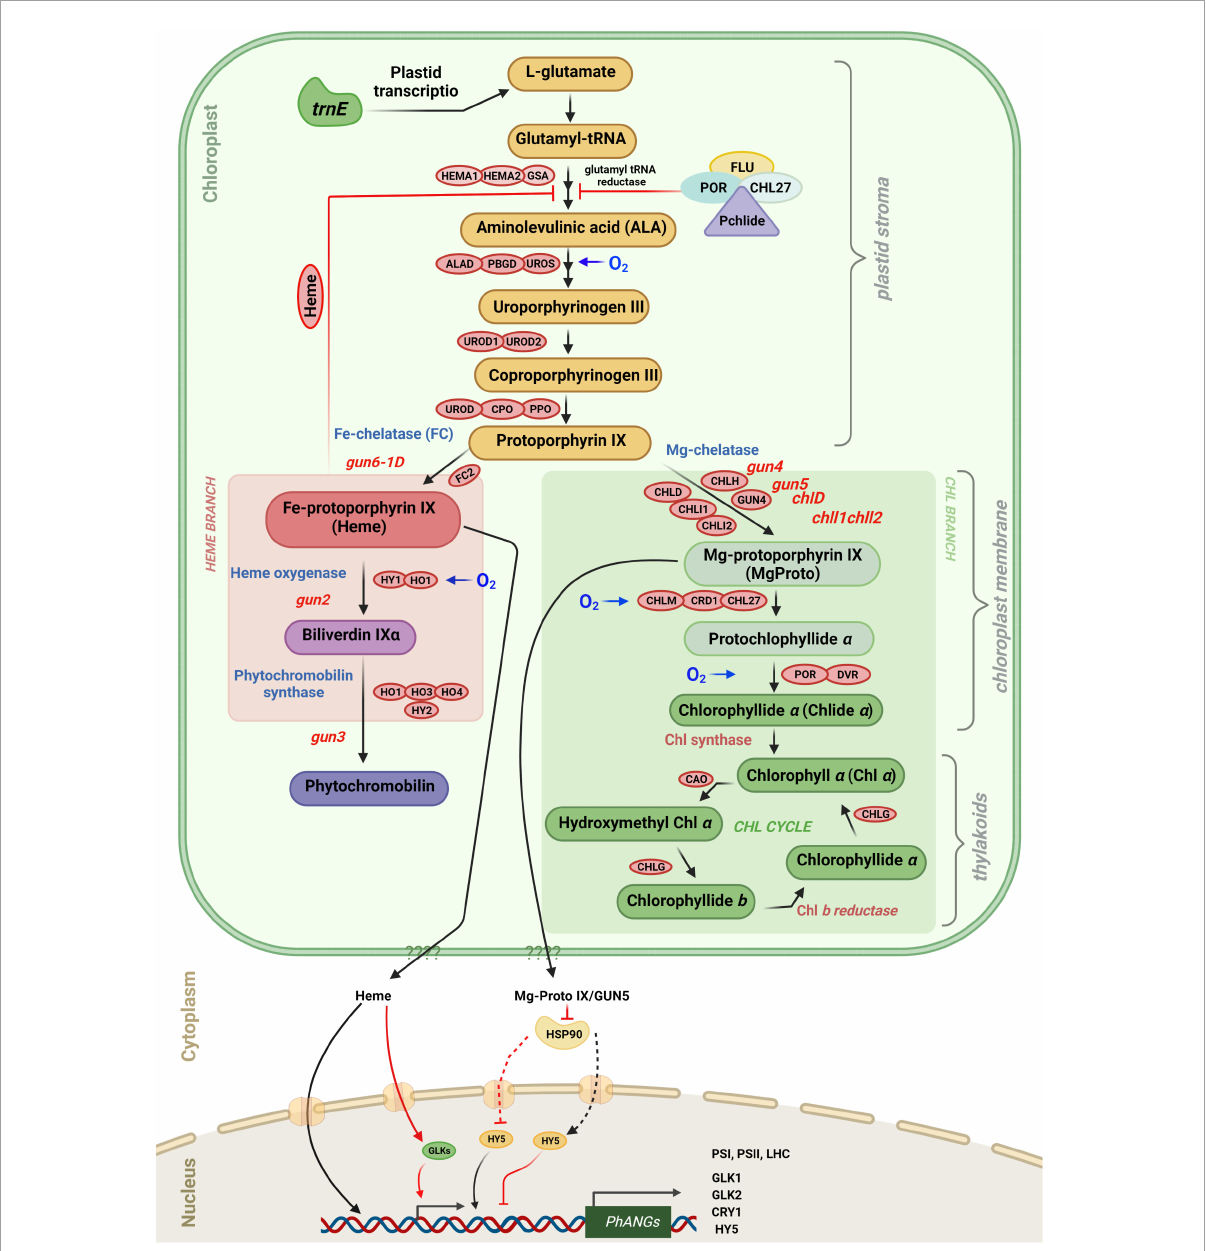
FIGURE5 Tetrapyrrole biosynthesis and plastid gene expression with key enzymes. Retrograde signaling is mediated in part by tetrapyrrole intermediates. The different steps in tetrapyrrole biosynthesis are indicated by arrows. FLU as well as the amount of “free” heme control the rate of